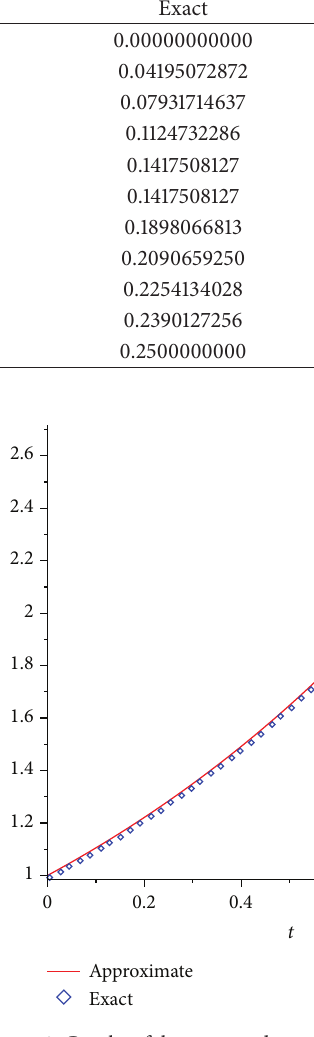
Figure 2: Graphs of the exact and computed solution of the problem for Example